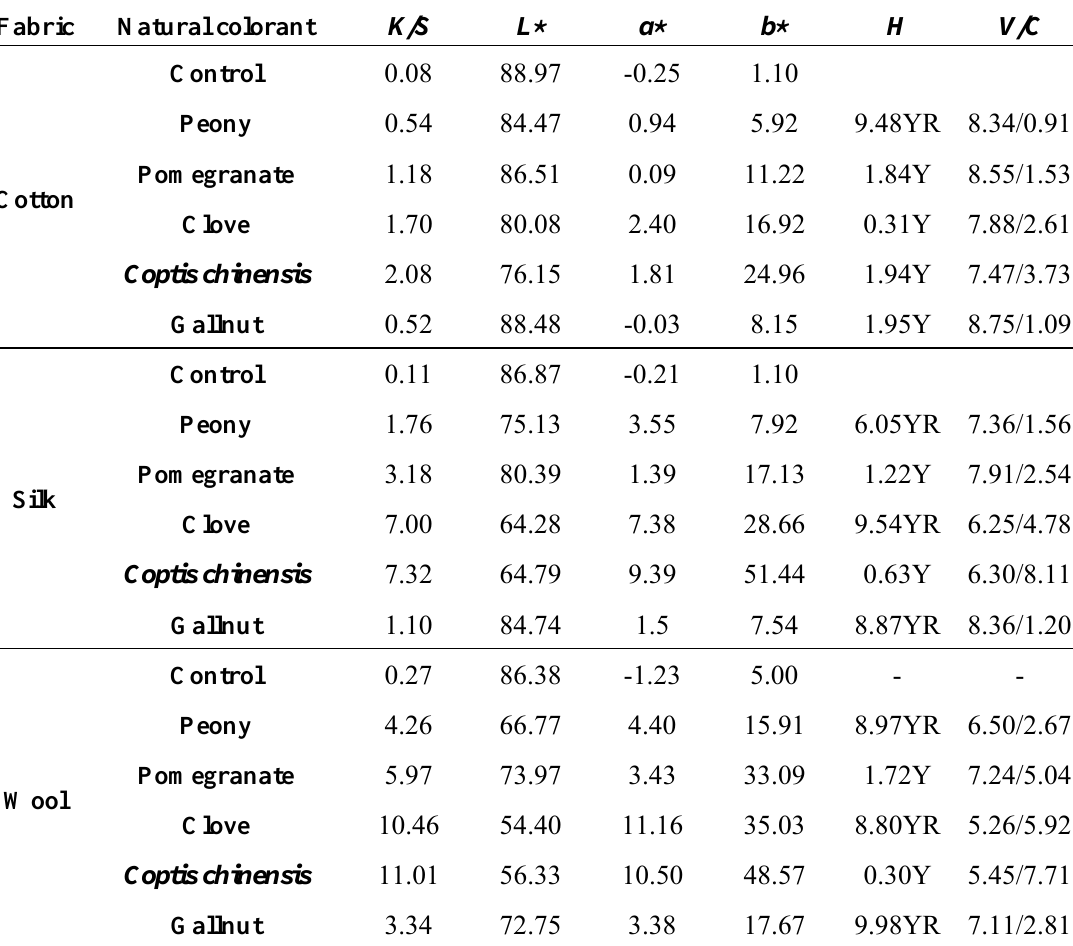
Table 1. Colorimetric data of fabrics dyed with p eony, pomegranate, clove, Coptis chinensis and gallnut extracts.